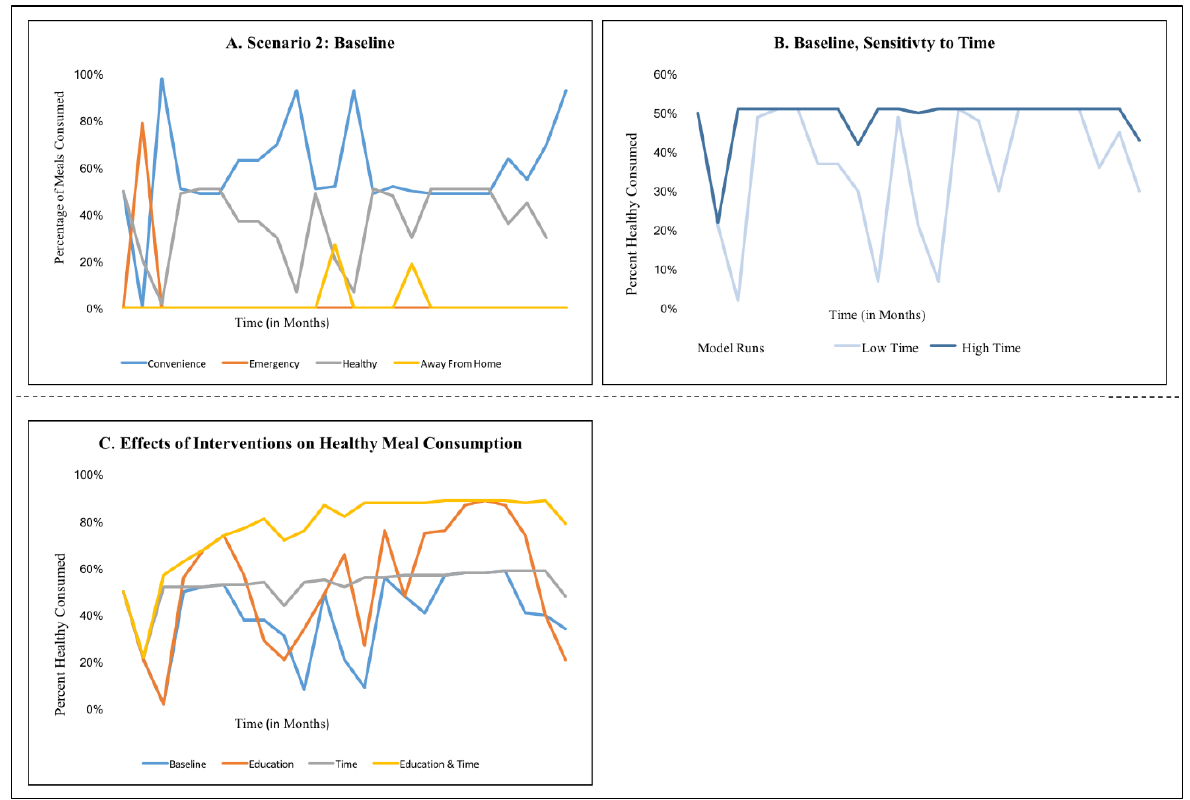
Figure 5. Scenario 2: Mid-Low Income, Car, Variable Work